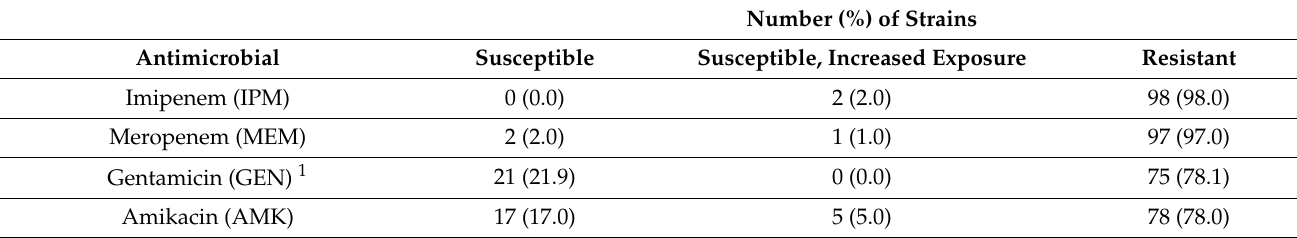
Table 2. Antimicrobial susceptibility of the studied strains ( n = 100). Number (%) of Strains Antimicrobial Susceptible Susceptible, Increased Exposure